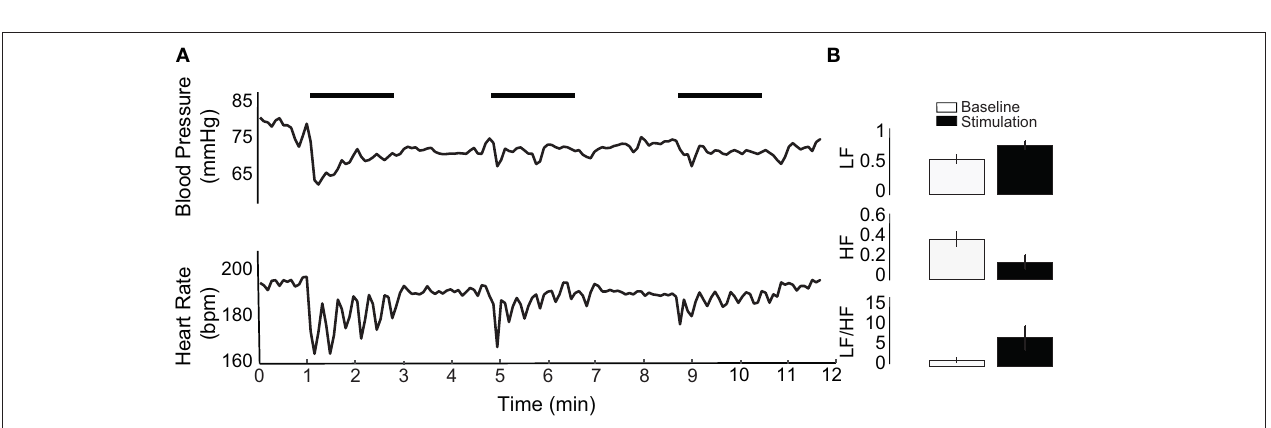
FIGURE 6 | Heart rate variability during pulsed IR targeting PC. (A) Shows an example of HRV changes in the LF, HF, and LF/HF components evoked by IR in one rat. Baseline responses, shown by white bars, were recorded for 2min prior to initiation of IR. Responses to stimulation, shown by black bars, were recorded for 2min during stimulation of the PC by IR. (B1) Shows the number of rats with an increase or decrease in LF/HF at each of the 17 rats’ stimulation threshold. (B2) Shows the number of stimulation periods that resulted in either an increase or decrease in LF/HF over all periods (113) in 17 rats, (sign test, p < 0.001). (C1,D1) Show the relationship between HRV (LF/HR ratio) and baseline levels of MBP or HR for responses to IR stimulation of the PC at 470 µ J/pulse in 6 rats which are color coded. (C2,D2) Similarly show the relationship between HRV (LF/HF ratio) and percent change in MBP (initial change MBP/MBP baseline, or percent change in HR (initial change HR/baseline HR) for responses to IR stimulation of the PC at 470 µ J/pulse in the 6 rats.